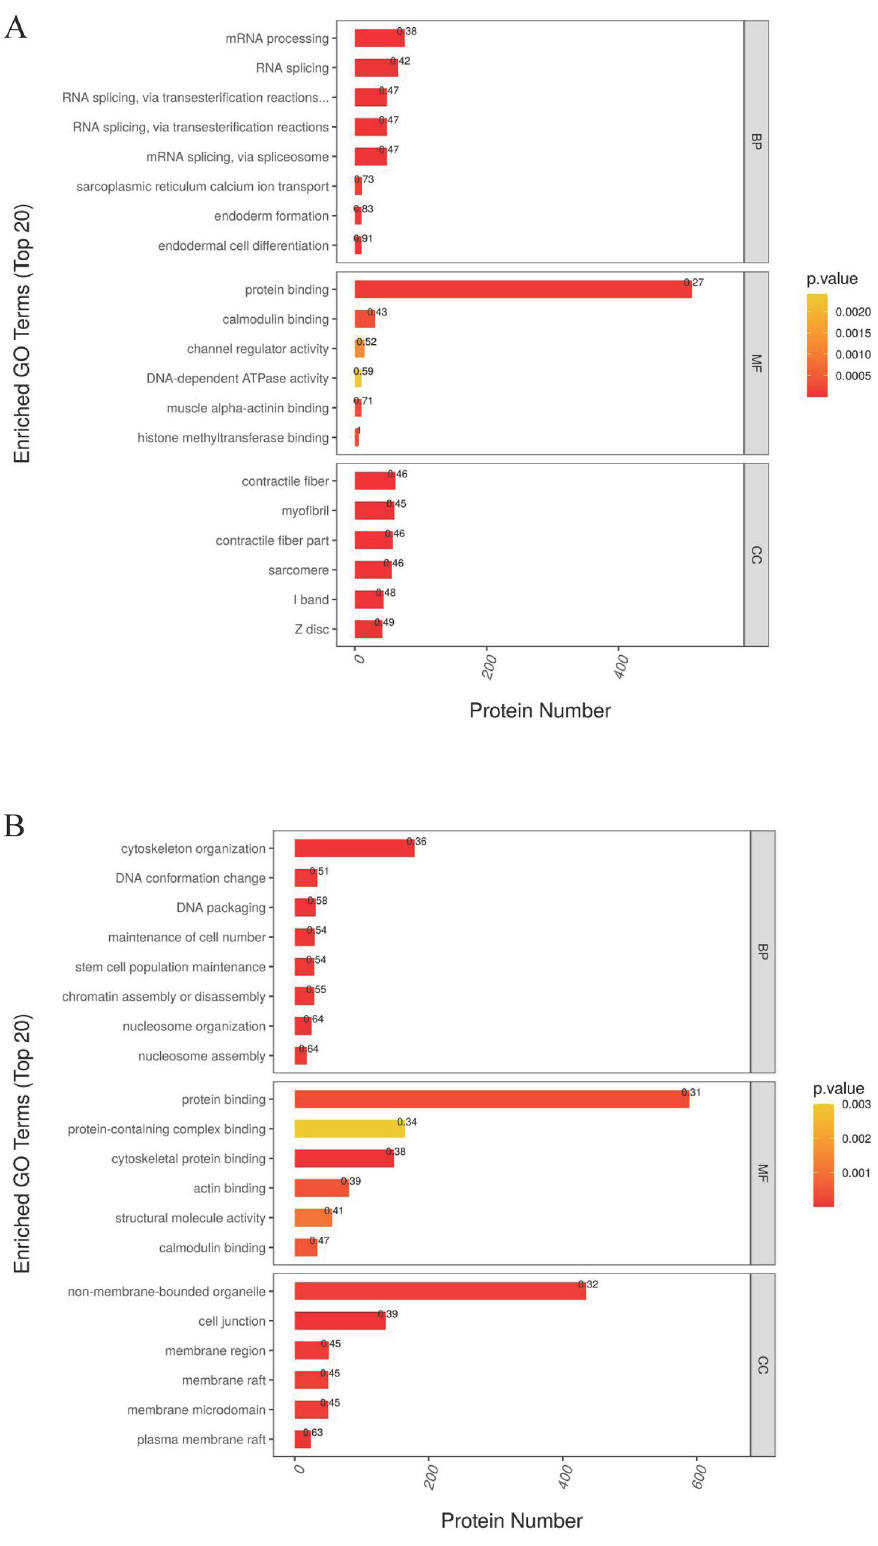
Figure 6. Gene Ontology (GO) functional enrichment analysis of differentially expressed protein of phosphoproteomics treated with PZH ( A ) and sora ( B ). Functional classification is divided into biological process (BP), molecular function (MF) and cellular component (CC). Red represents the smaller p value than orange, corresponding to the higher significance level of the enrichment of the functional category. The label above the bar graph shows the enrichment factor, which indicates the ratio of proteins of differentially expressed phosphorylated peptide to identified and annotated phosphorylated